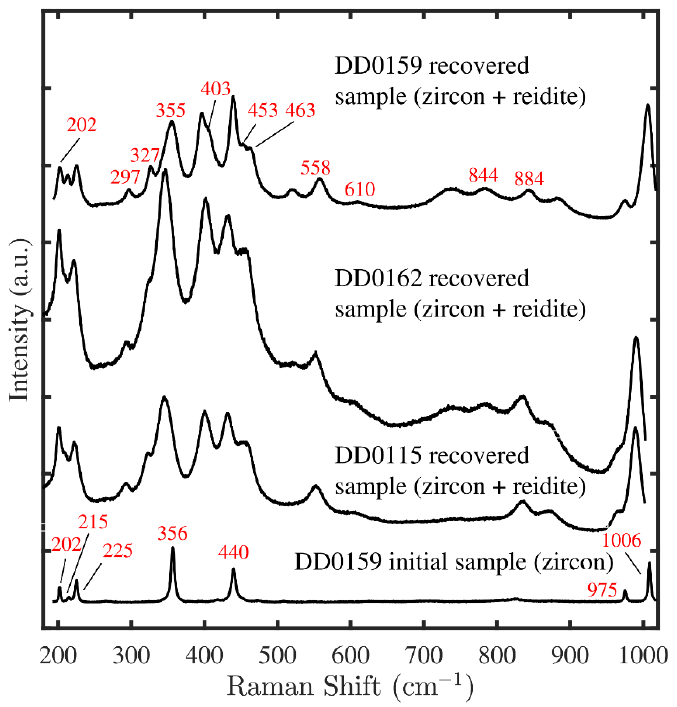
Figure 1. Raman spectra of the initial and recovered samples in the experiments. Due to the overlap of the peak, we cannot distinguish the peak at 202 cm − 1 as belonging to reidite or zircon in the spectrum of recovered sample DD0159. The characteristics of the zircon Raman spectra at different pressures are listed in Figure 2. In DD0115, new peaks were observed at 508 and 611 cm − 1 at 19.5 GPa; they are labeled by blue and red arrows in Figure 2a and are attributed to the B g (3) and E g (4) vi ‐ brational modes of reidite, respectively, while these two vibrational modes are located at 463 and 558 cm − 1 under ambient conditions. Likewise, in DD0162(2), the B g (3) and E g (4) modes of the reidite were observed at 18.7 GPa, as denoted with blue and red arrows in Figure 2b, respectively. In DD0159, the E g (4) modes of reidite was observed at 16.0 GPa, as denoted with a red arrow in Figure 2c, and the B g (3) mode was not observed, possibly due to the low signal ‐ to ‐ noise ratio at high P–T. Our results indicate that zircon–reidite phase transitions occur at 19.5, 18.7, and 16.0 GPa when the temperature is 298, 373, and 473 K, respectively.